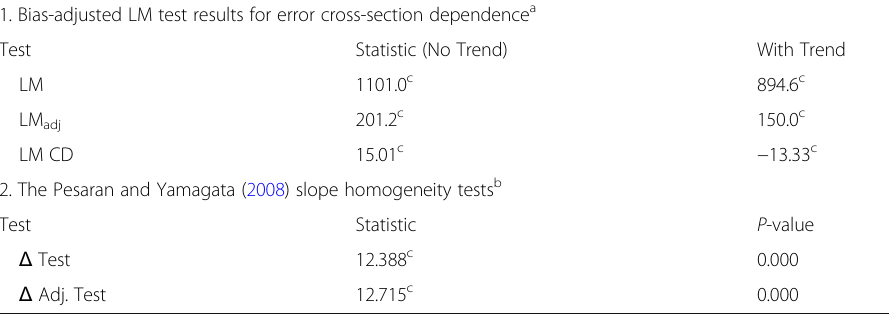
Table 5 Cross-sectional dependence and homogeneity